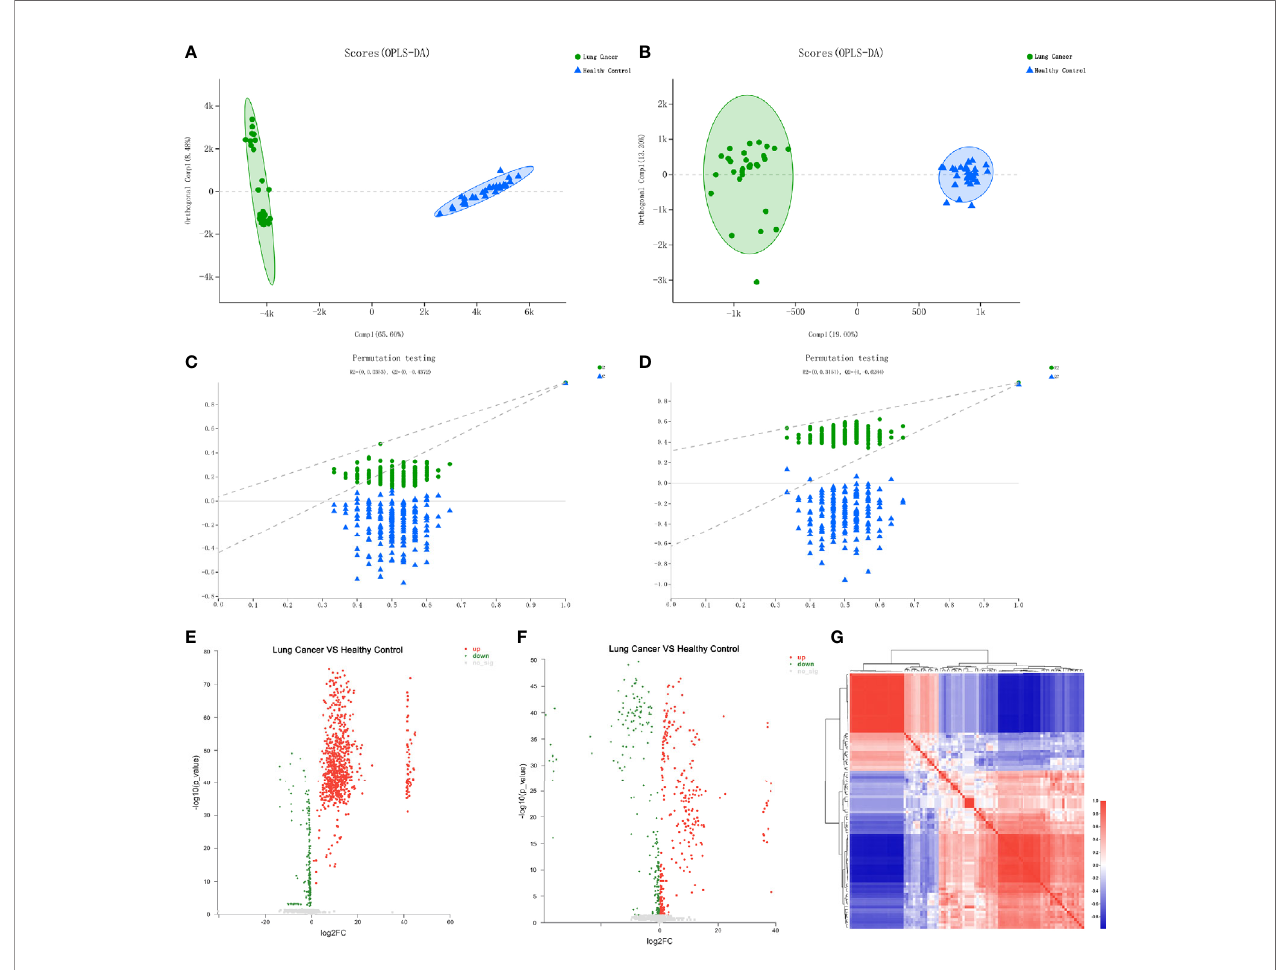
FIGURE 3 | Differential metabolite analysis of serum from the lung cancer group and the healthy control group. (A) OPLS-DA score of the lung cancer group and the healthy control group in the negative ion mode. (B) OPLS-DA score of the lung cancer group and the healthy control group in the positive ion mode. (C) OPLS-DA differential metabolite serum anion permutation testing. R 2 = (0, 0.0353), Q 2 = (0, -0.4372). (D) OPLS-DA differential metabolite serum cation permutation testing. R 2 = (0, 0.3151), Q 2 = (0, -0.6284). (E) Volcano plot of serum anion metabolites in the control group and lung cancer group. (F) Volcano plot of differential metabolites of serum cations in the healthy controls and lung cancer group. (G) Metabolite heat map of serum differences between healthy controls and lung cancer